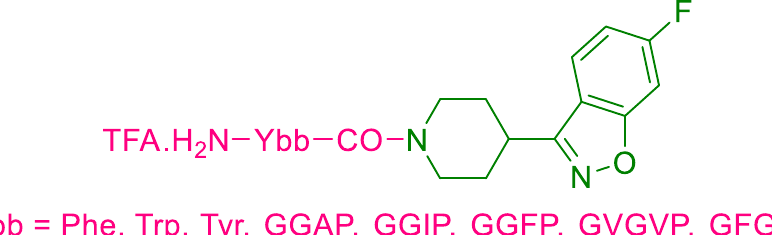
Figure 34. Amino acids conjugated to benzisoxazole derivatives.